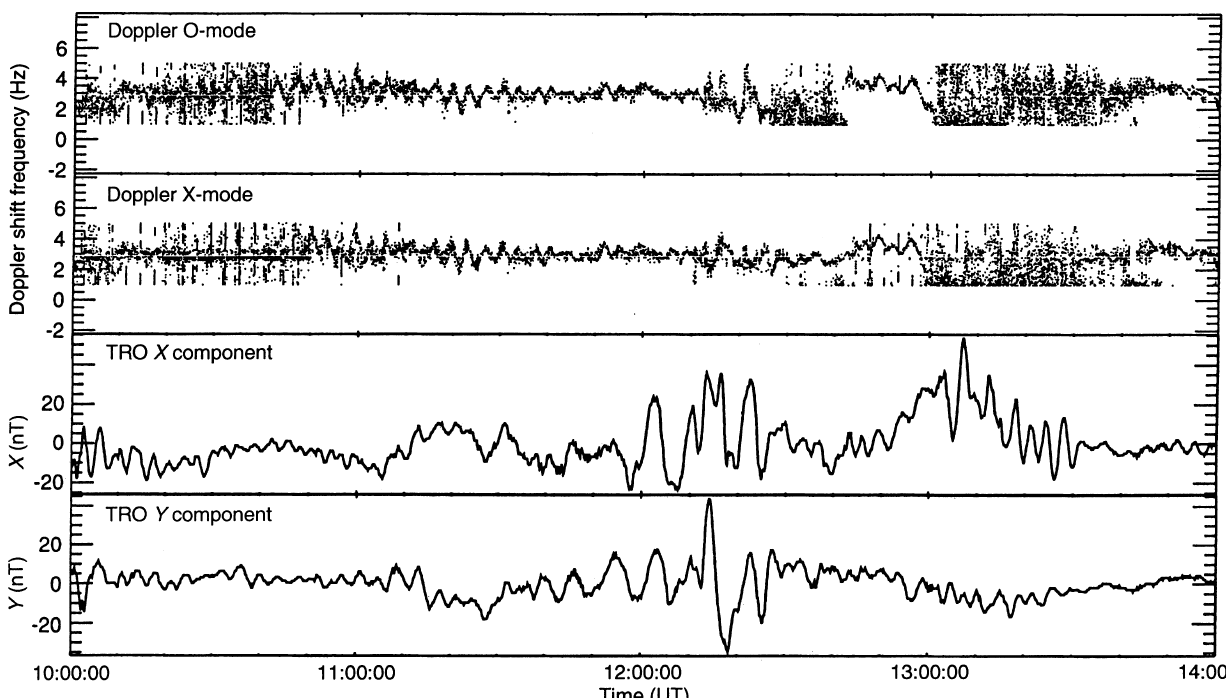
(cid:109) Fig. 2. HF Doppler and magnetometer data for the ULF wave event on 13 February 1996. The panels display (from the top down): Doppler O-mode frequency shift, X-mode frequency shift, TRO X - component and TRO Y -component. The sampling interval of the Doppler data is 12.8 and 10.0 s for that from the magnetometers. The Doppler data are plotted above a threshold of 50% of the amplitude of the main spectral component for each FFT